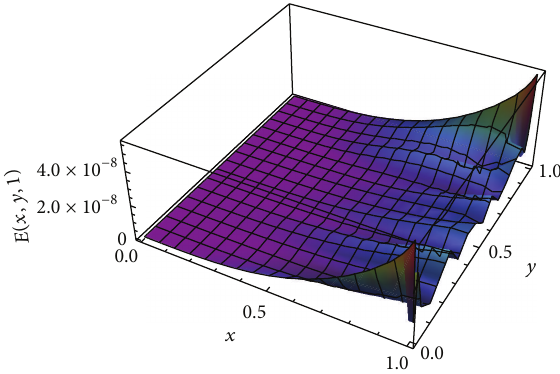
Figure 2: Space graph of absolute error of problem